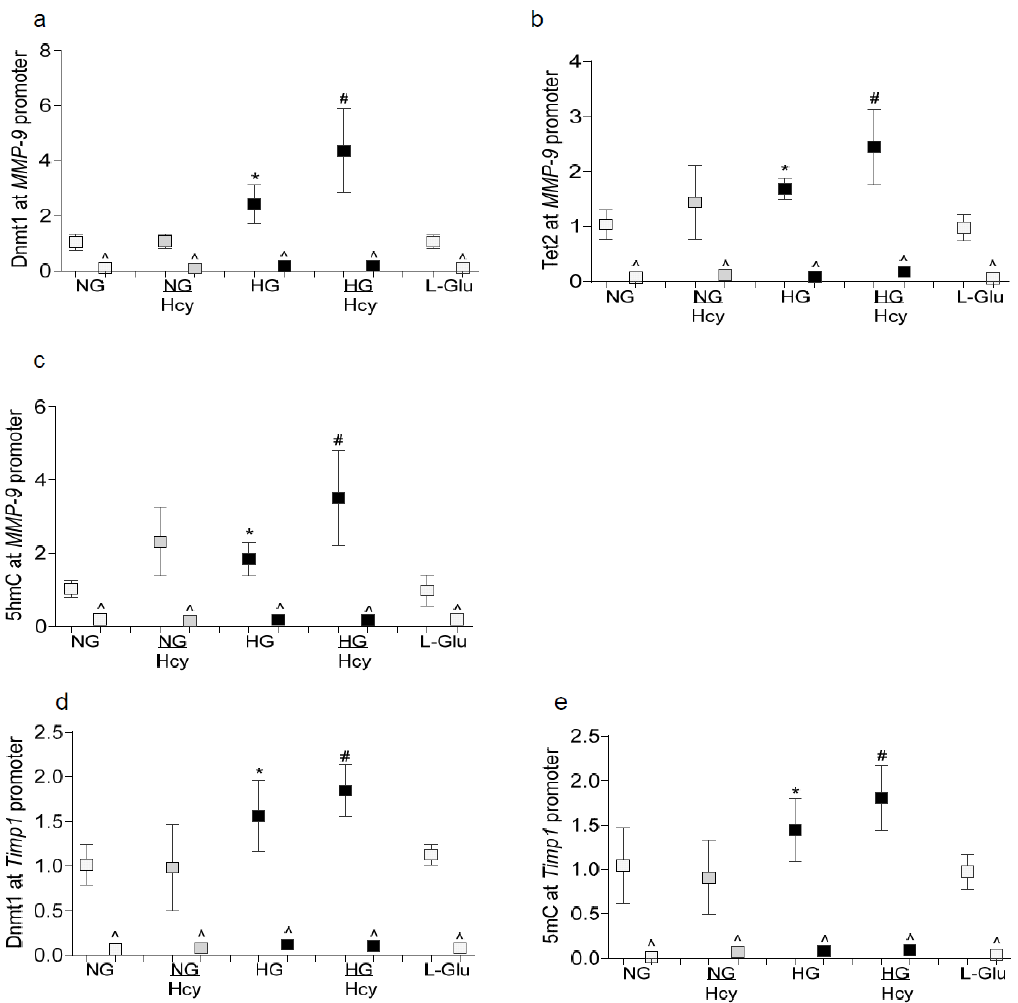
Figure 4. Effect of homocysteine on DNA methylation status of MMP-9 and Timp-1 promoters. The promoter region of MMP-9 was analyzed for ( a ) Dnmt1 and ( b ) Tet2 binding by the ChIP technique and ( c ) 5hmC levels by the hydroxymethylated DNA immunoprecipitation method. ( d ) Dnmt1 binding and ( e ) 5mC at Timp1 promoter were quantified by the ChIP technique and the methylated DNA immunoprecipitation method respectively. IgG (^) was used as an antibody control. Each measurement was made in duplicate in three to four different cell preparations. NG and HG = 5 mM and 20 mM glucose, respectively, NG/Hcy and HG/Hcy = cells treated with homocysteine in 5 mM or 20 mM glucose, L-Glu = 20 mM L-glucose. * p < 0.05 vs NG and # p < 0.05 vs HG.